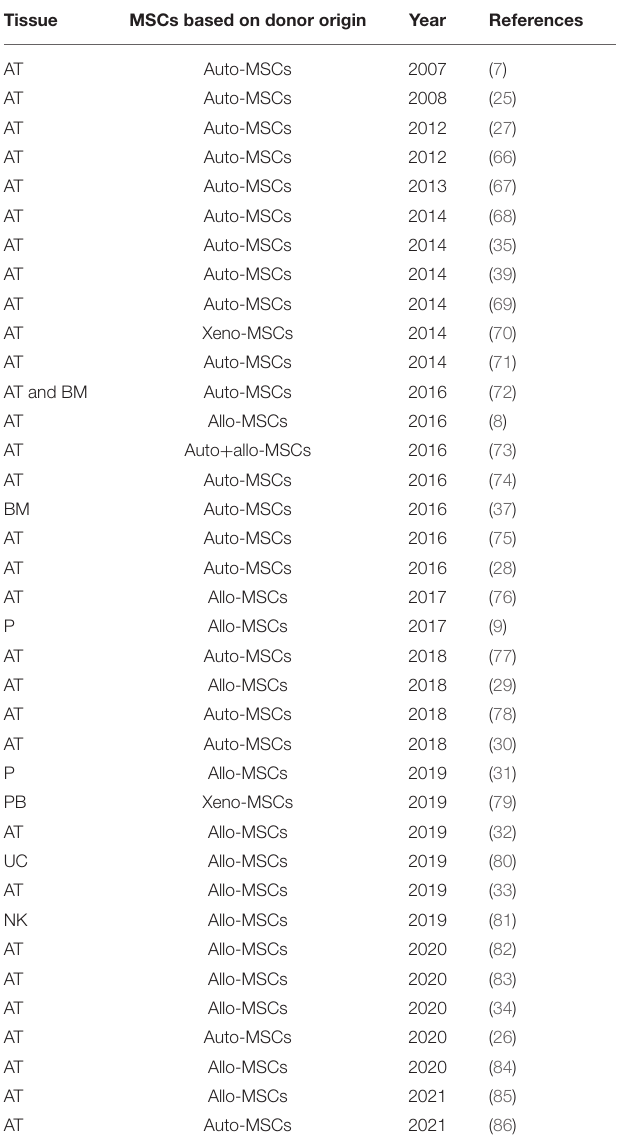
TABLE 1 | The most common tissue and donor sources for MSCs used in canine OA clinical